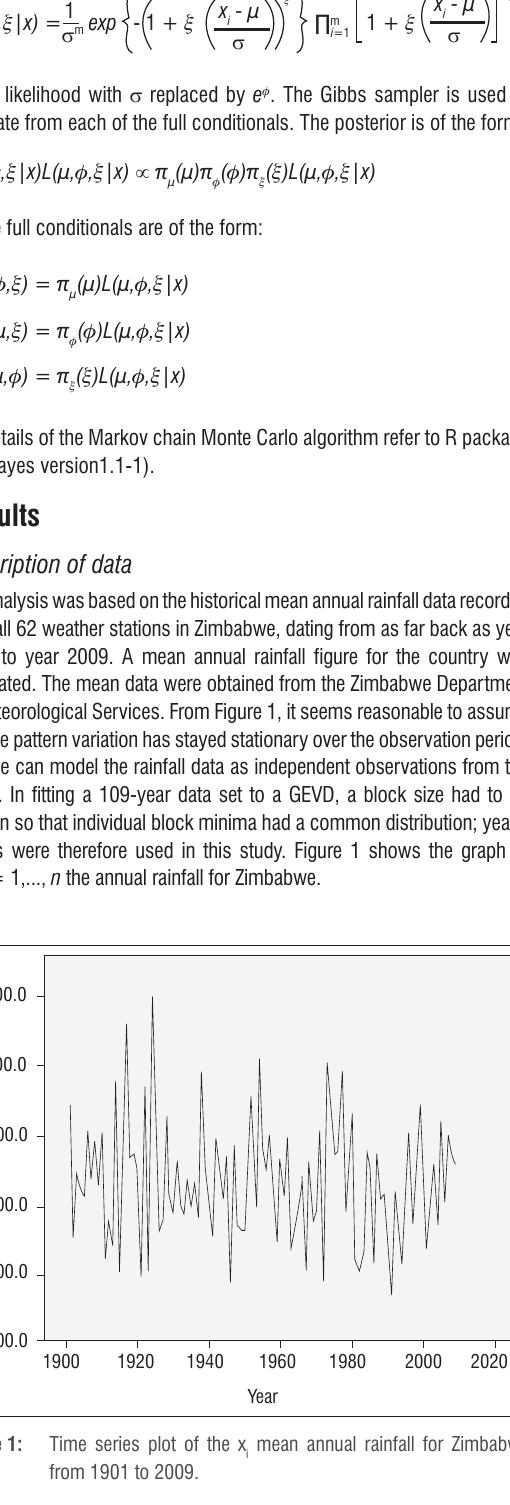
Time series plot of the x from 1901 to